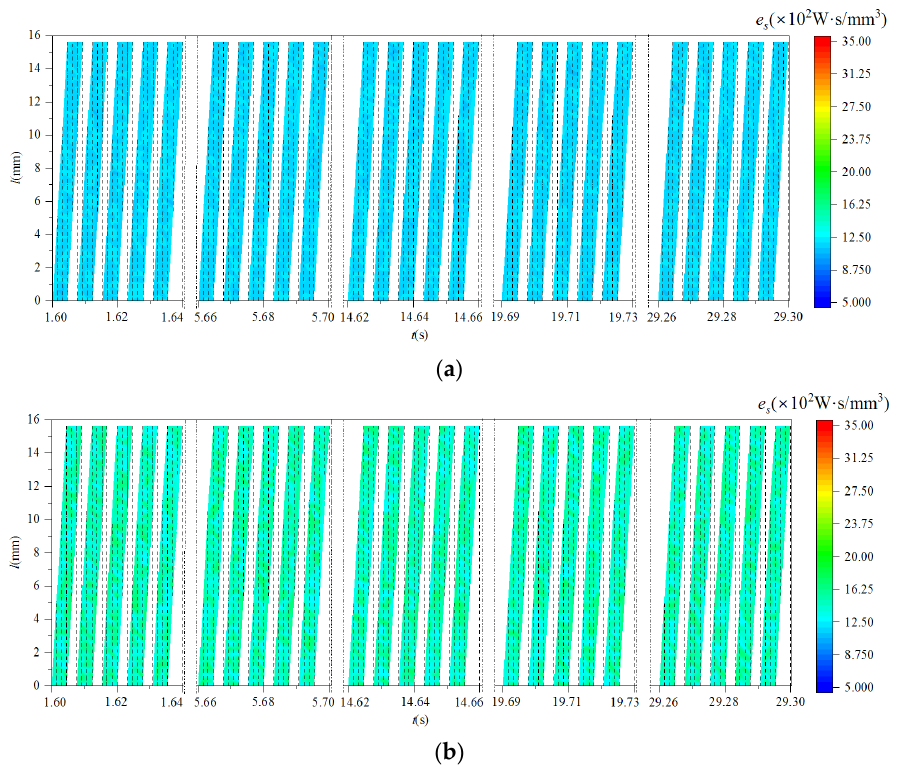
Figure 14. The distributive variation in instantaneous shear energy efficiency of cutting edge with and without vibration. ( a ) Without milling vibration; ( b ) with milling vibration.